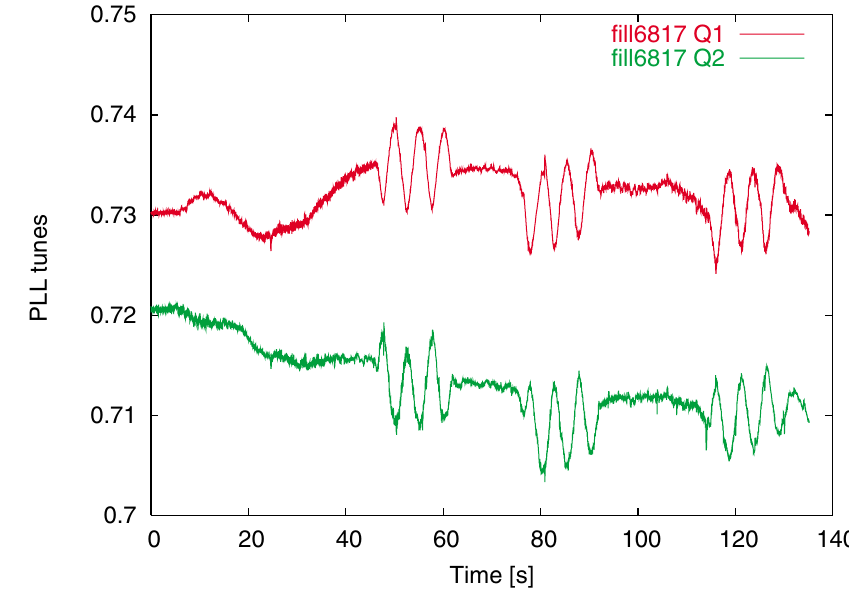
FIG. 4. (Color) The Yellow ring tunes in the first ramp with coupling angle modulations.